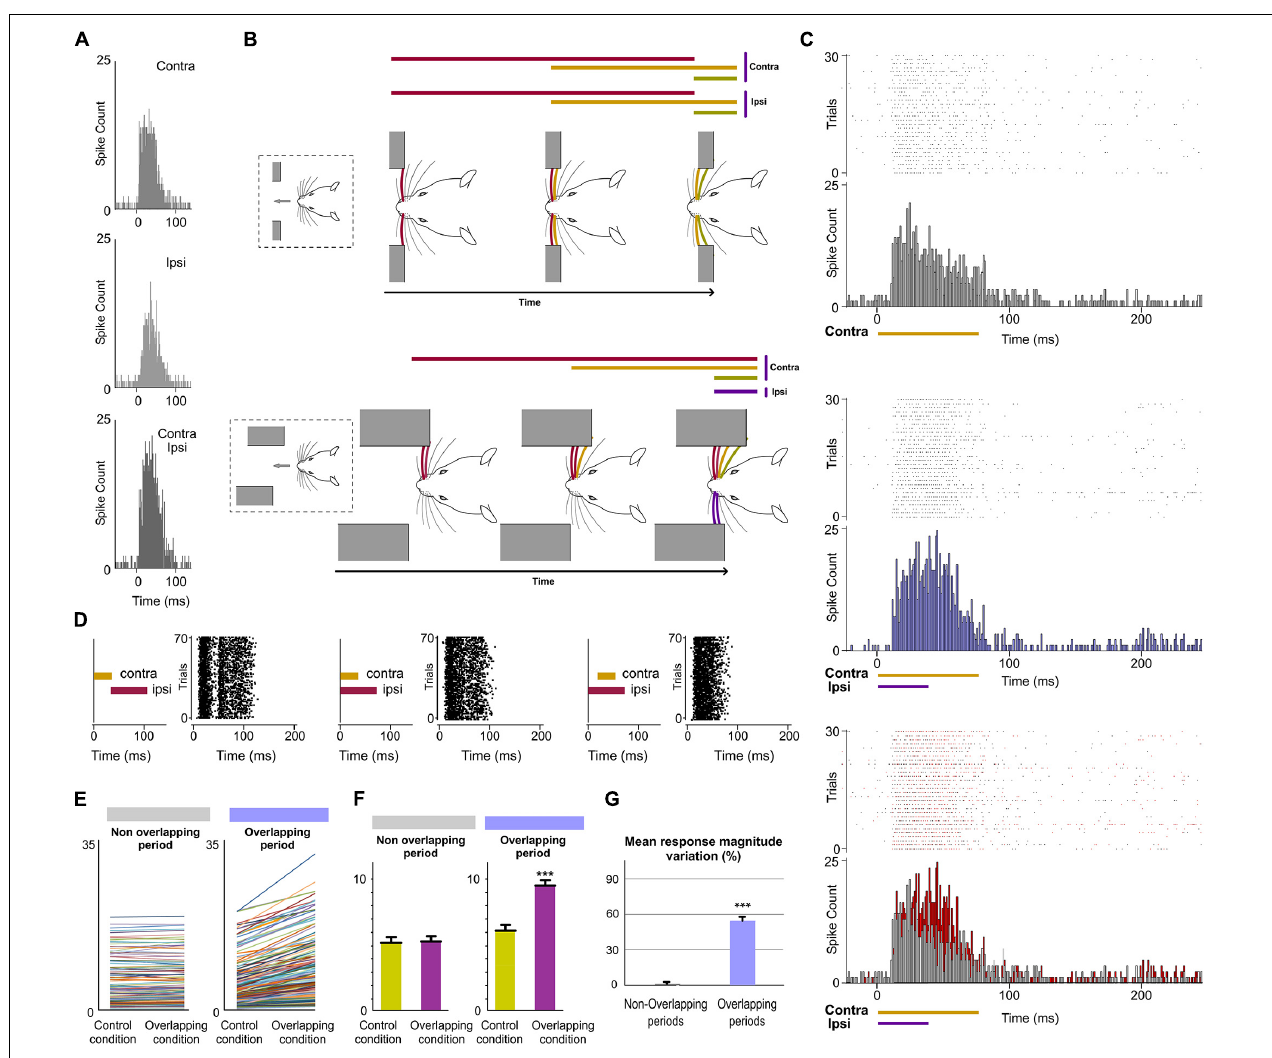
FIGURE 11 | POm integration of bilateral events. (A) PSTHs of POm responses evoked by contra-, ipsi- and bilateral whisker stimulations (stimulus duration 40 ms; 30 trials shown for each stimulus). To visualize the facilitative integration of bilateral signals, contra- and ipsilateral evoked responses are displayed separately. (B) As can be appreciated in these two simulated tactile sequences, many whiskers on both sides are sequentially deflected simultaneously. In our experiments, bilateral sensory patterns were generated by the application of contralateral and ipsilateral stimuli activating different subsets of whiskers on both sides of the face at mirror (matched whiskers on each side) and non-mirror positions. (C) Raster plots and PSTHs showing demonstrative POm responses evoked by contralaterally (top) and bilaterally (middle) evoked overlapping stimulation using stimuli with different durations. Note that the time shared by these bilateral overlapping inputs is encoded by a precise increase in POm activity. This increment is depicted in red in the bottom panel. (D) The time interval between contralateral and ipsilateral stimuli was varied to produce different overlappings and to study their integration. Raster plots of POm responses to different bilateral overlapping stimulation protocols are shown. As can be appreciated in the left panel, no integration was observed when the contra- and ipsilateral stimuli were not temporally overlapped. (E) Data showing the quantification of the facilitative integration during overlappings of contralaterally and ipsilaterally evoked signals. Plots comparing the spike rate of all recorded multi-units ( n = 187, depicted in different colors) during the Overlapping and Non-overlapping response periods in Control and Overlapping conditions across bilateral sensory patterns. (F) The mean firing rate was significantly increased in the Overlapping periods ( p < 0.001; Wilcoxon matched-pairs test) but not in the Non-overlapping periods where the mean magnitude of responses did not change ( p = 0.41; Wilcoxon matched-pairs test). (G) Mean response magnitude variation (%) between control and overlapping conditions in Non-Overlapping and Overlapping periods ( p < 0.001, Wilcoxon matched-pairs test). *** P <